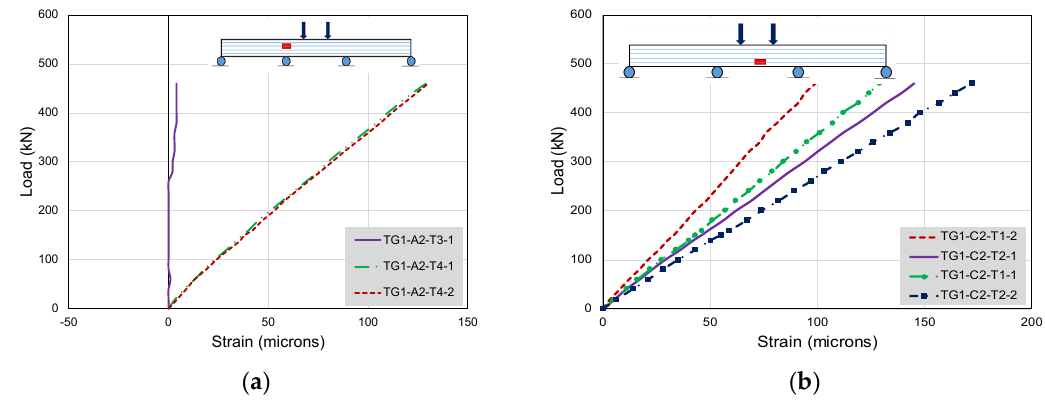
Figure 39. Load versus strain responses in load setup SP-1-L02 ( a ) A2 and ( b ) C2.